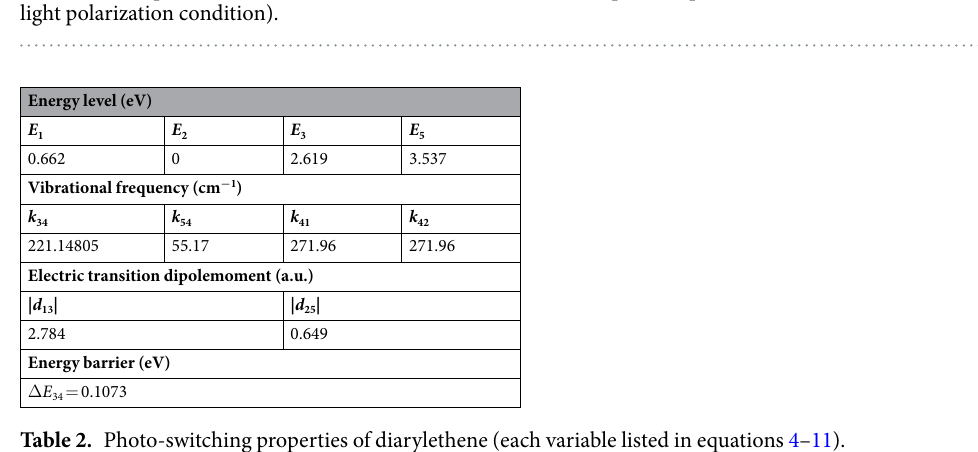
Figure 3. ( a , b ) Population of each molecular state for cyclization ( n uv = 2.0 * 10 26 photons/s, and θ UV = 0). ( c , d ) Population of each molecular state for cycloreversion (